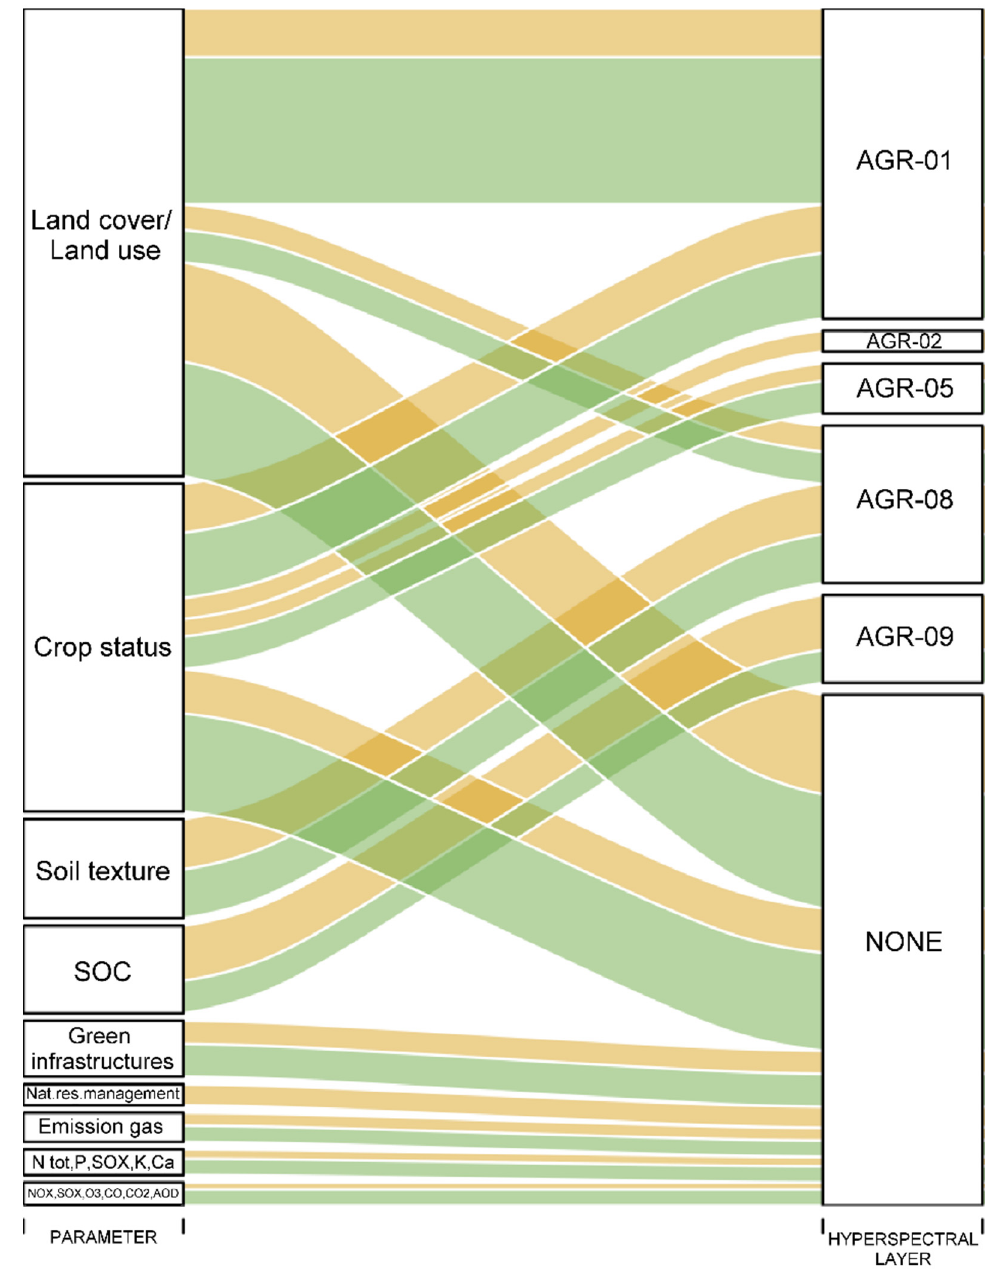
Figure 7. Sankey diagram representing the link between required parameters (left hand side column) and available layers from hyperspectral sensor data related to the “AF” thematic area (AGR-xx), as requested by the Environmental control system community (reported in spicy mustard) and CREA (reported in green). The thickness of each connecting line represents the number of times the parameter is requested by the considered community to satisfy the user requirement. Layer coding was defined within the study as an alphanumeric and unambiguous code for each product. The code “NONE” indicates an unavailable hyperspectral layer.